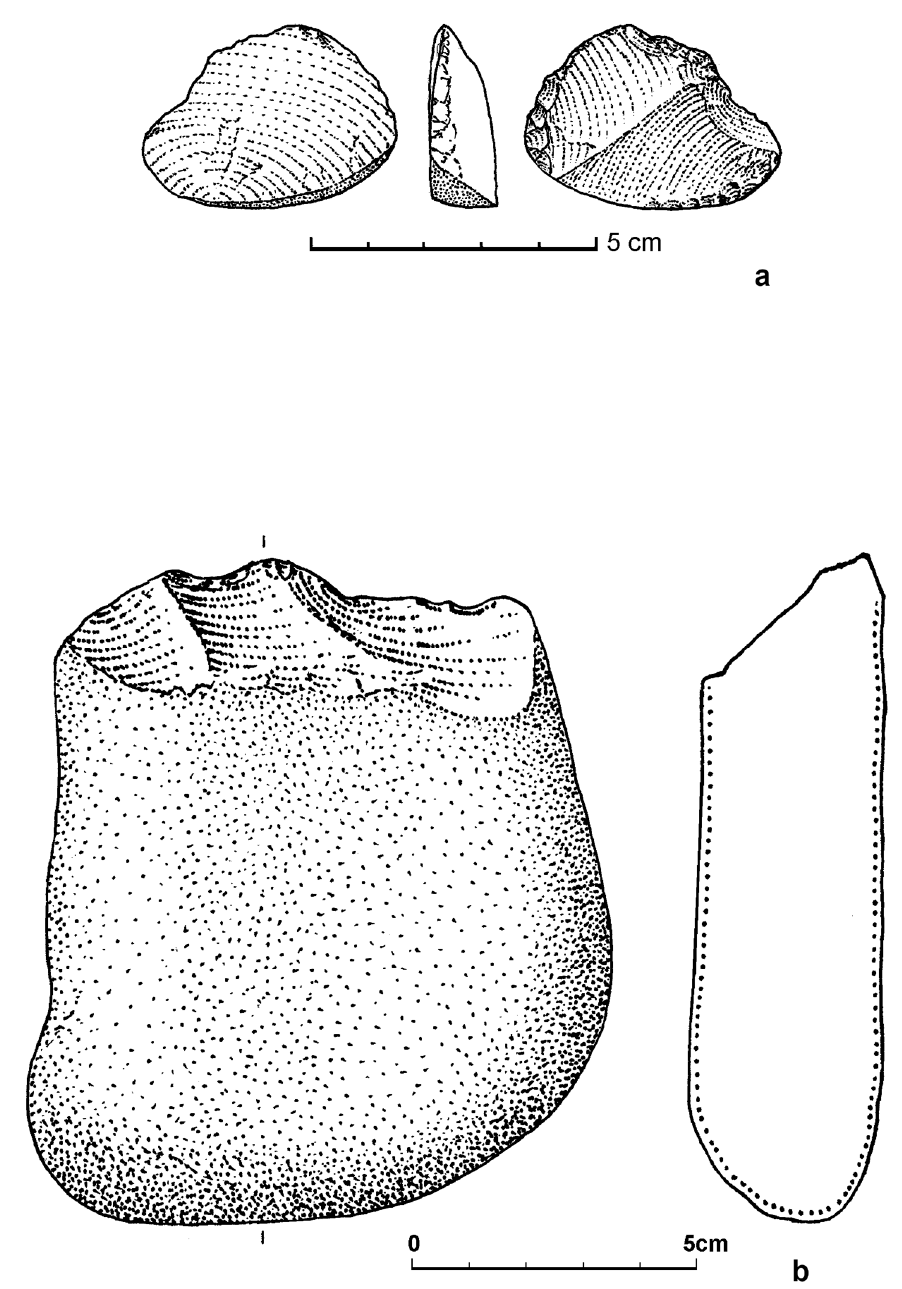
Figure 9. Münster-Sarmsheim. ( a ) Retouched quartzite flake (‘scrapper’) in situ out of the terrace; ( b ) Chopper—fallen down from a sandy layer within the terrace. (Drawings: L. Fiedler.). Lithic artefacts a) − c) were recovered from thin, but very wide sand lenses (several metres long)